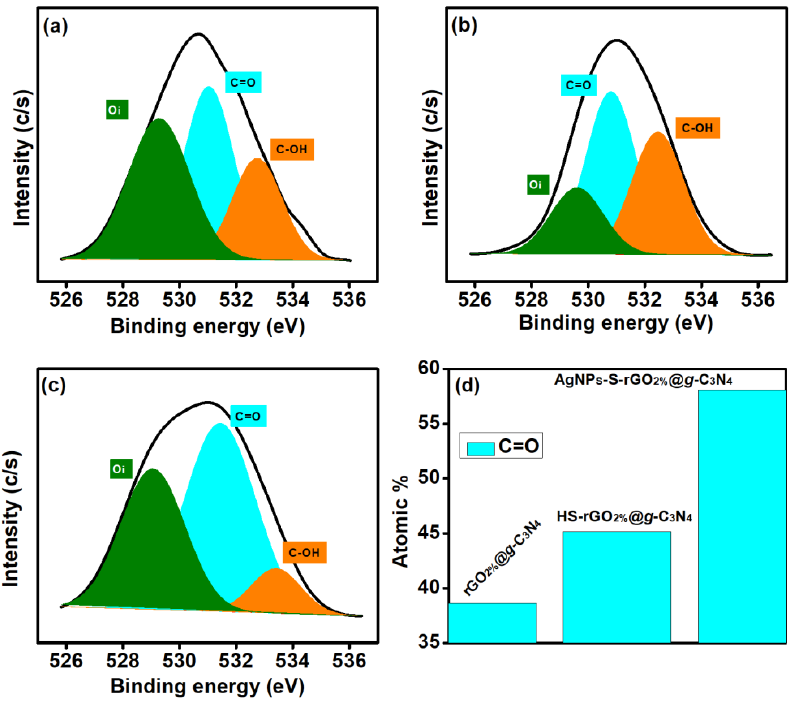
Figure 5. O1s-attached functional groups ( a ) rGO 2% @ g -C 3 N 4 , ( b ) HS-rGO 2% @ g -C 3 N 4 ( c ) AgNP S -S-rGO 2% @ g -C 3 N 4 and ( d ) increment in C=O bonding of rGO 2% @ g -C 3 N 4 , HS-rGO 2% @ g -C 3 N 4, and AgNP S -S-rGO 2% @ g -C 3 N 4 . The S2p spectrum analysis of HS-rGO 2% @ g -C 3 N 4 (Figure 6a) shows two peaks at